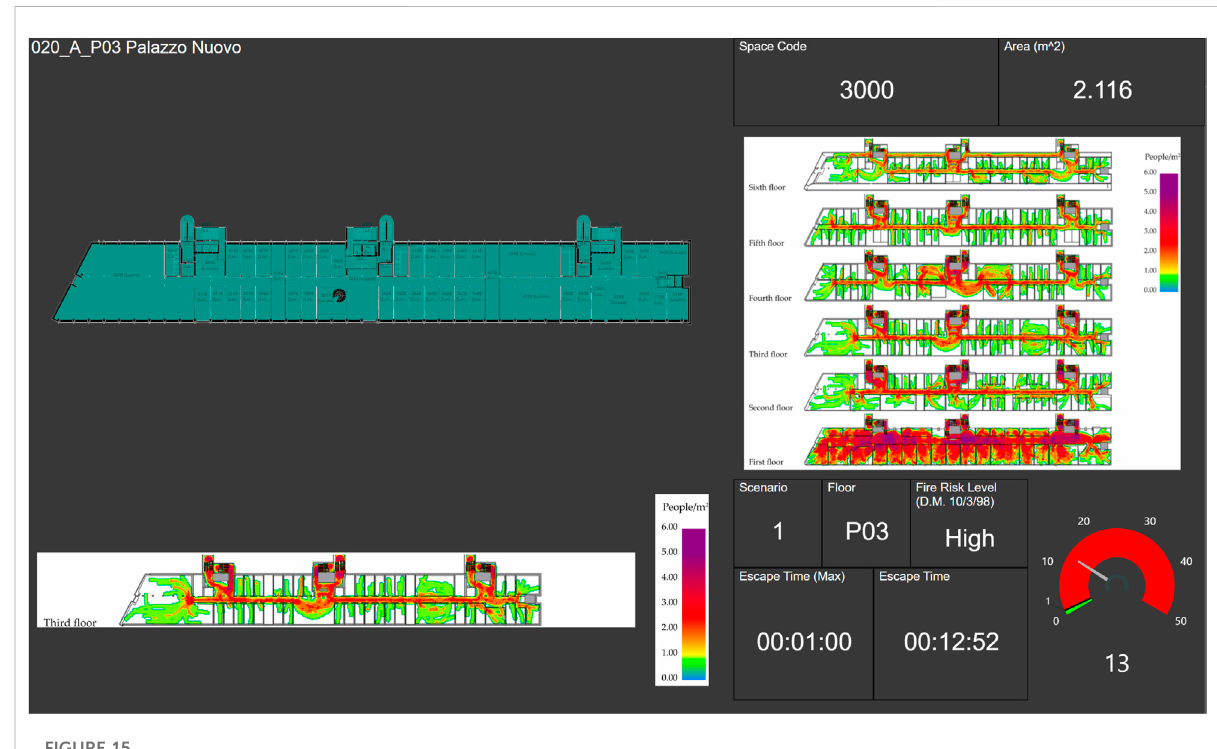
FIGURE 15 Example of space analysis dashboard for Palazzo Nuovo with hosted courses